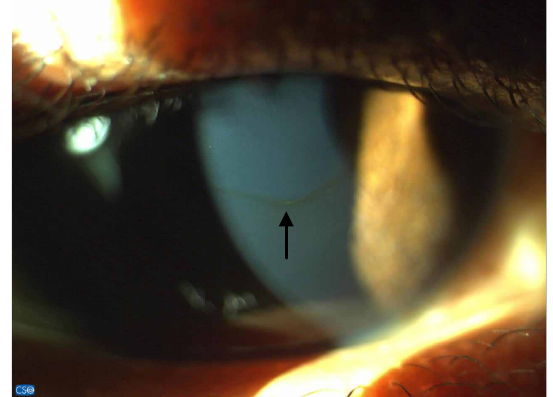
Figure 6 . An obvious Fleischer’s ring indicated by the arrow.